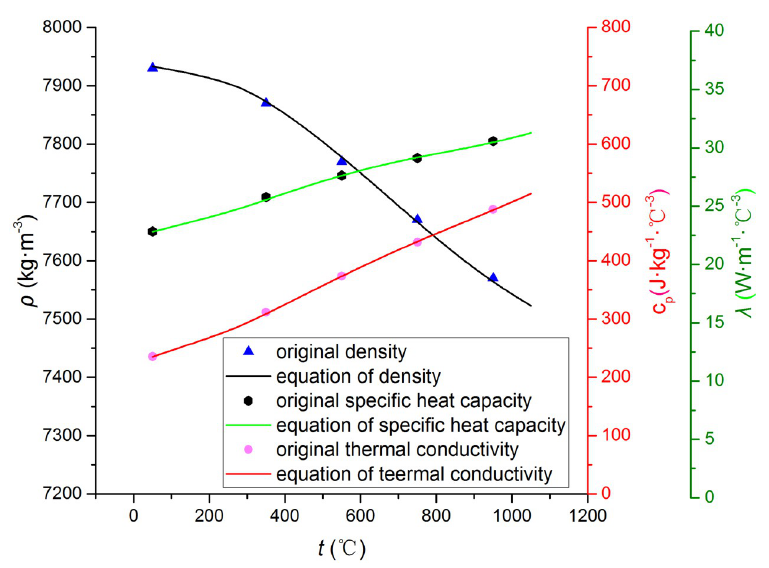
Fig 7. Comparison between the fitting polynomials and the original